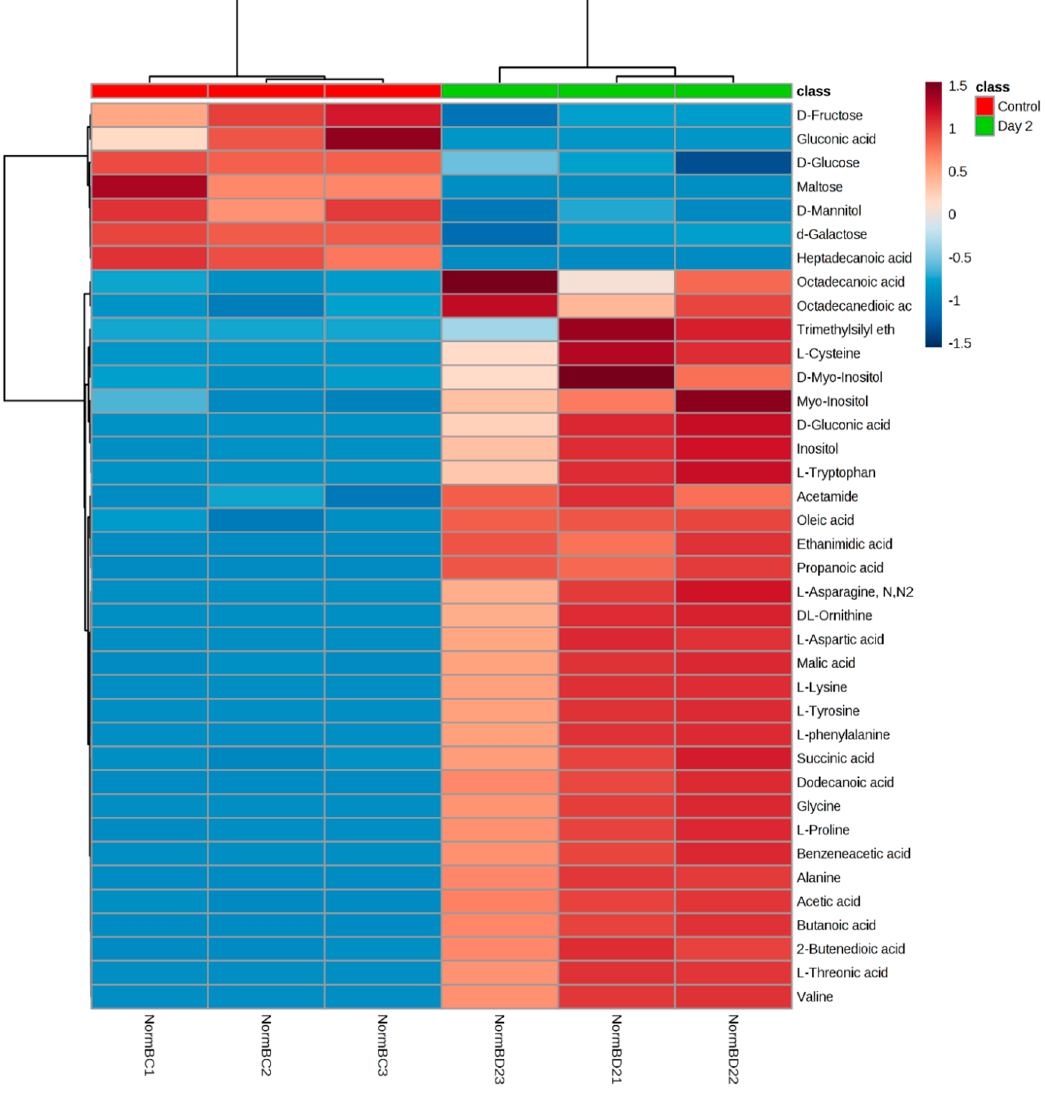
Figure 1. A heatmap analysis of metabolites variations. Fermentation was carried out for 2 days and metabolites were analyzed by gas chromatography-mass spectrophotometry (GC-MS). The unfermented brewers’ spent grains (BSG) samples, in triplicate, are displayed from the left, followed by the fermented BSG samples, in triplicate. The areas shaded in red indicate a higher amount of the specific metabolites, whereas the areas shaded in blue indicate a lower amount of the specific metabolites.